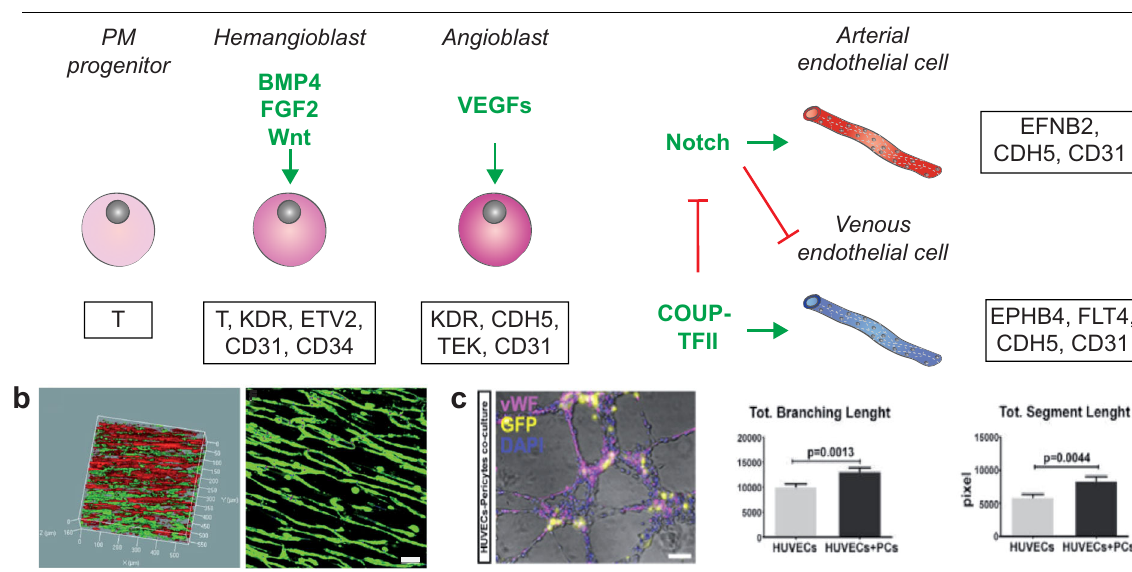
Fig. 6 Vasculogenesis, endothelial cell development, and co-culture with skeletal muscle cells: in fl uence on myogenesis. a Representation of the formation of primary vessels during vasculogenesis, with endothelial cell differentiation starting from the paraxial mesoderm (PM) progenitor. Marker genes are shown in the bottom boxes, while the main signaling molecules are indicated in green if acting as pro- differentiative actors, in red if they inhibit the differentiation process. b Fluorescence confocal images of a co-culture of HUVECs (50%, in green) and muscle cells (50%, in red) in a fi brin matrix (left image). Focus on the endothelial network formation of HUVEC alone (right image). Scale bars: 50 μ m. Images adapted and reproduced with permission from 177 . c Fluorescence image of HUVECs (von Willebrand factor, magenta) in co-culture with primary pericytes (GFP) showing the formation of a network. Nuclei were identi fi ed by DAPI staining (blue). The graphs show the quanti fi cation of the tubular structures, in terms of total segment length, total mesh area, and total branching length of HUVECs without (grey columns) or with pericytes (black columns). Images adapted and reproduced with permission from 19